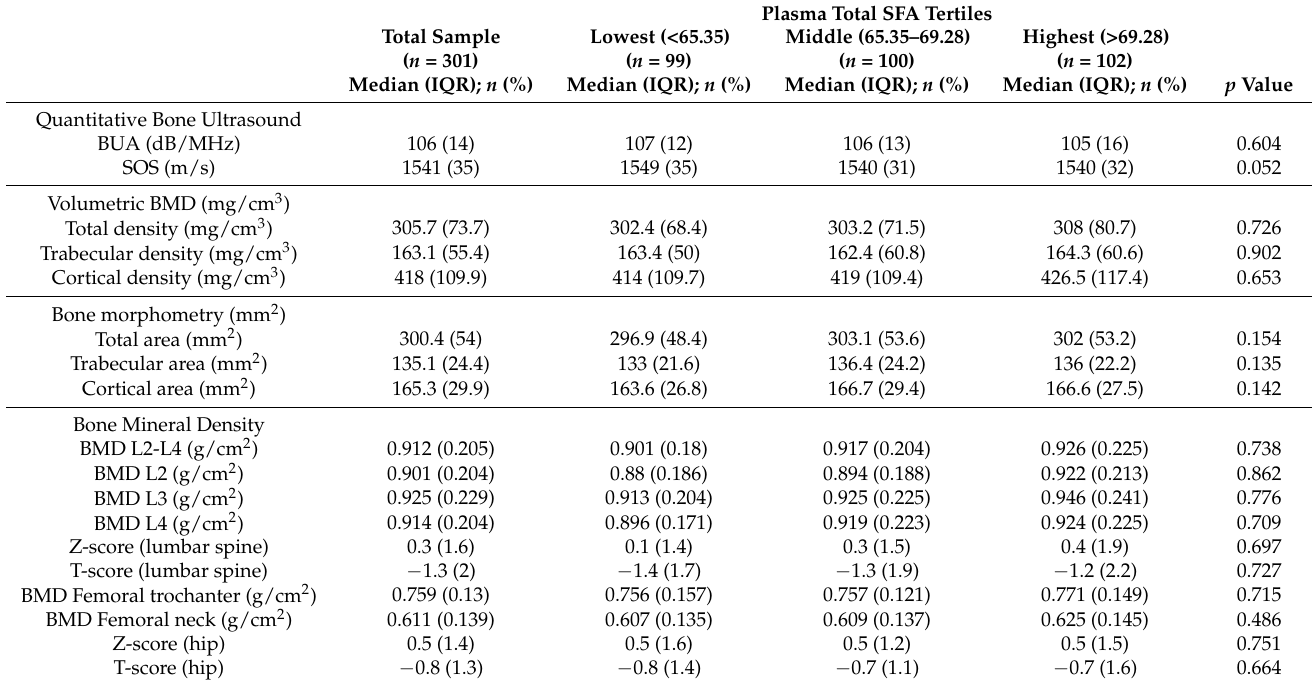
Table 6. Bone parameters by tertile of plasma Saturated Fatty Acids